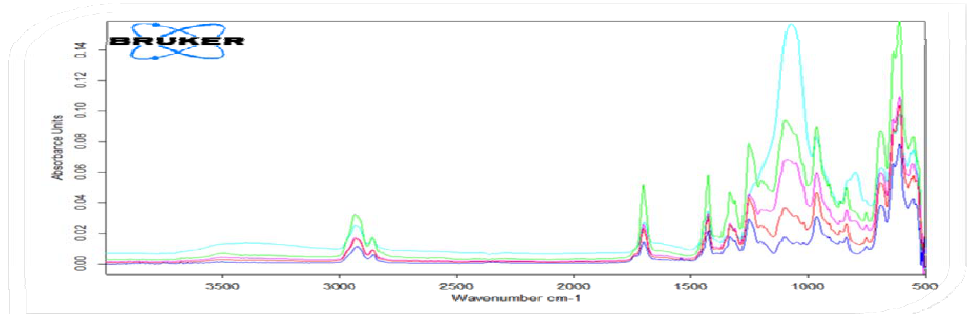
Fig. 17: FTIR spectra of pure PVC and its